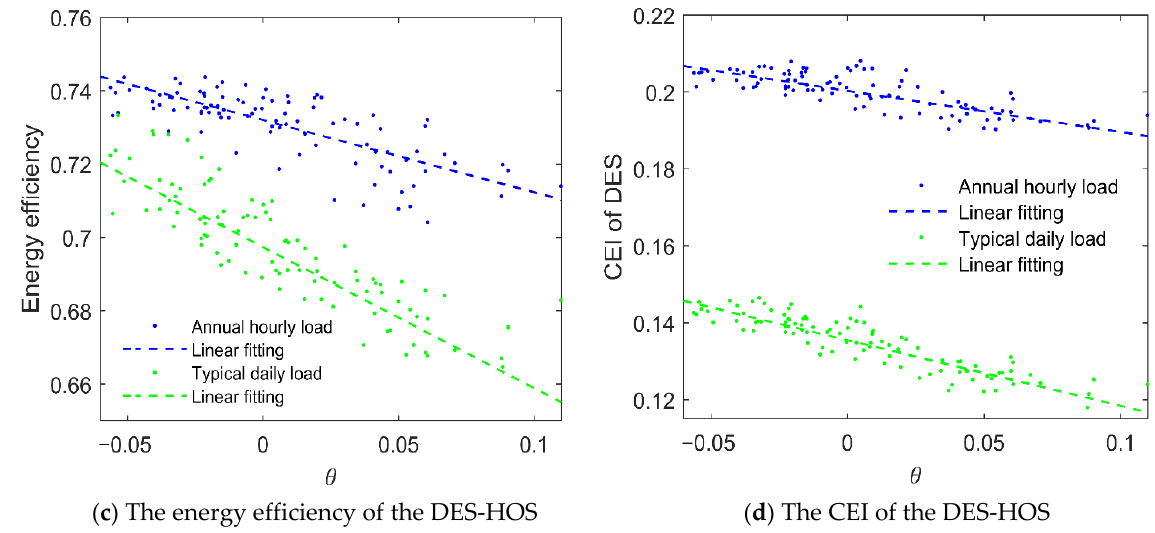
Figure 10. Variations of the DES-HOS annual total cost ( a ), carbon emission ( b ), energy efficiency ( c ) and CEI ( d ) with the rise in load fluctuation.